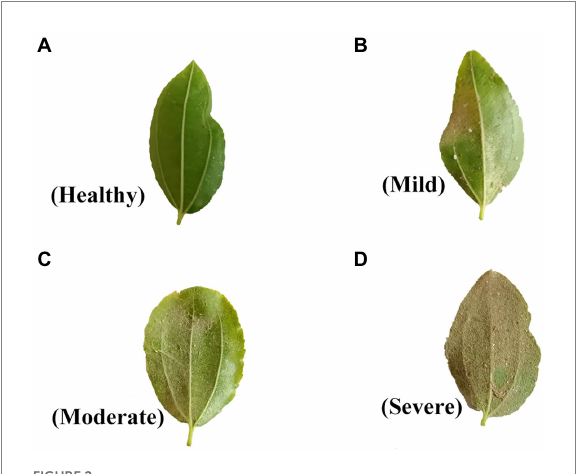
FIGURE 2 Different degrees of leaf mite infestation in jujube severity.